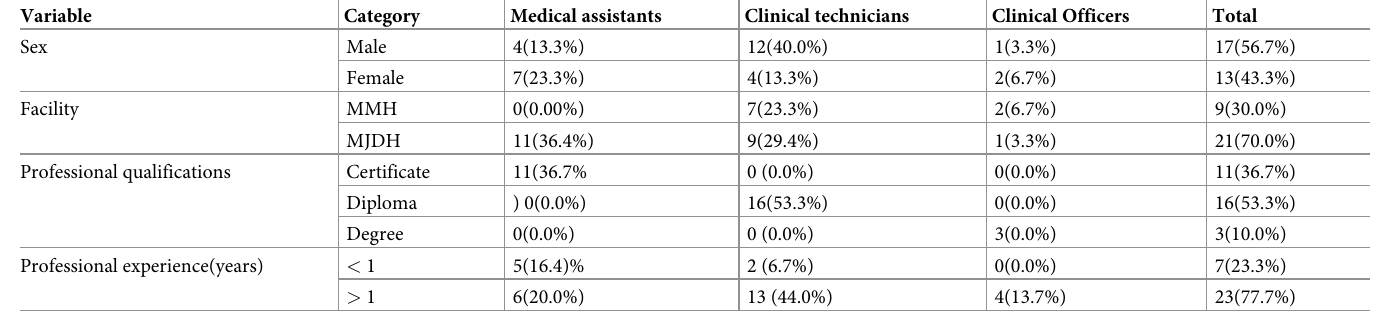
Table 1. Demographic characteristic of clinicians who participated in the study at chonde health center, chambe health center, Mulanje Mission Hospital and Mulanje District Hospital.